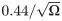
Stochastic single-cell simulations in the absence of extrinsic noise.
A. Typical single-cell simulations with Ω = 4. Green curves represent the fluorescence intensity and the black curve is the average of 500 simulations (results of 50 simulations are shown). B. Dependence of variability in oscillation amplitude on the scaling parameter, Ω. Decreasing Ω increased the level of intrinsic noise and hence the variability in the amplitude of the oscillations (red circles). The experimentally observed amplitude variability (dashed line) is achieved when Ω = 0.9. The solid black curve corresponds to 0.44/Ω, obtained by fitting a function proportional to 1/Ω to simulated data. C. Single-cell simulations with Ω = 0.9 show that, while amplitude variability matches that seen in experiments, the model period is much more variable (CV = 0.47).